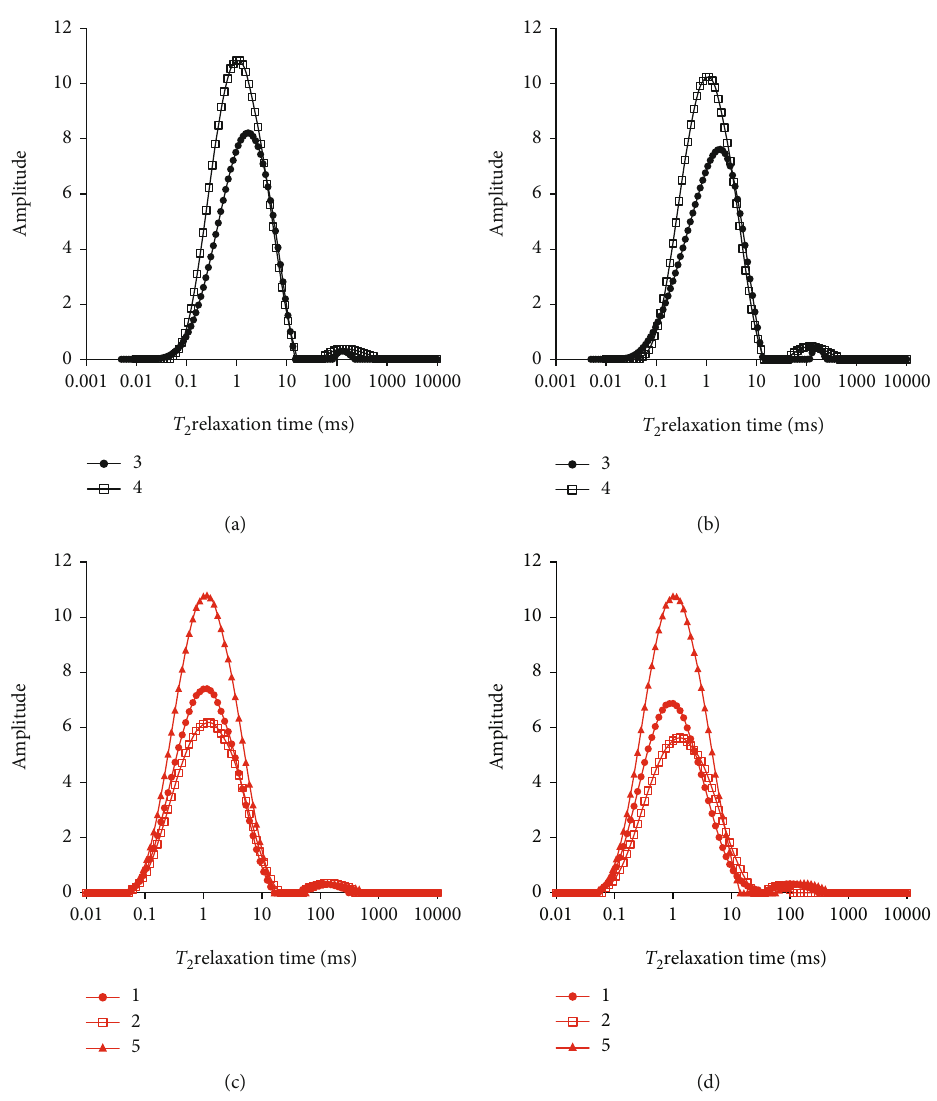
Figure 5: T spectrum of BMHS (a) before and (b) after centrifugation; CMHS (c) before and (d) after centrifugation. 2